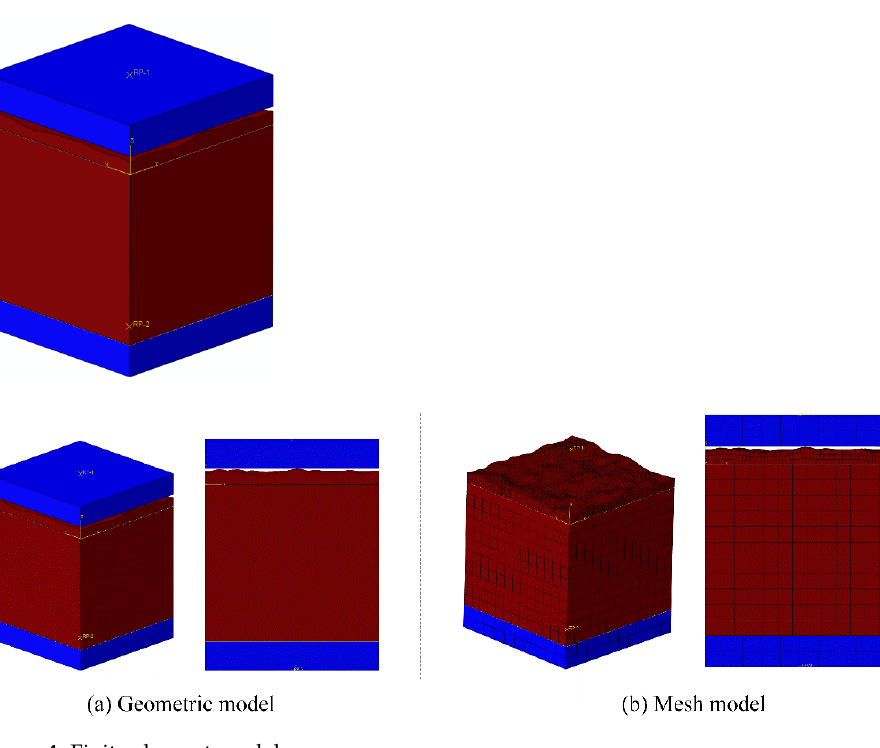
Figure 4. Finite element model. Table 1. Material parameters of the NiTi alloy.